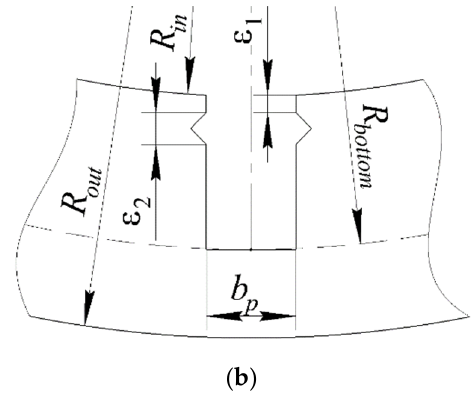
Figure 5. Parameters of the WRSM. ( a ) Rotor; ( b ) stator.